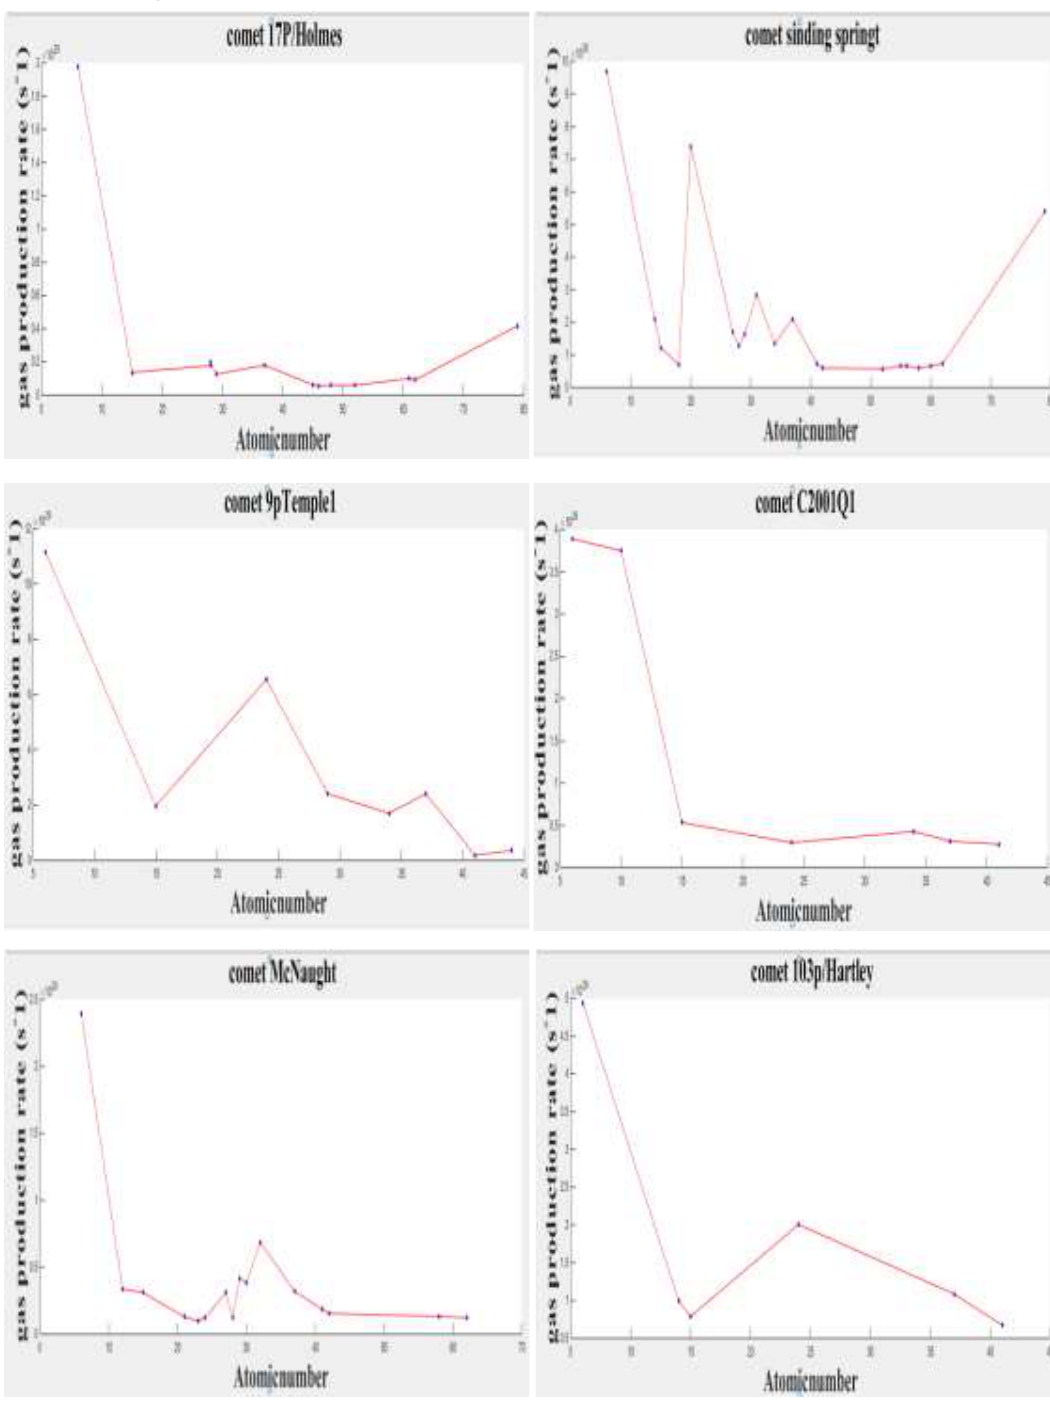
Figure 5: Gas production rate as a function of atomic